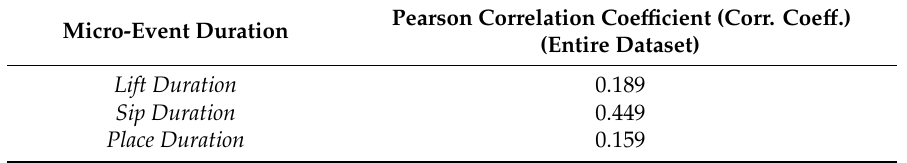
Table 2. Correlation between features and volume label.